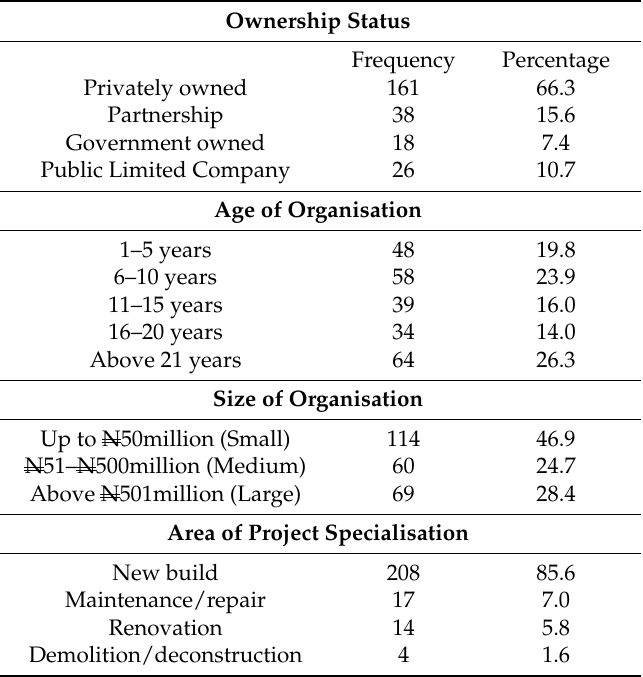
Table 3. Organisations’